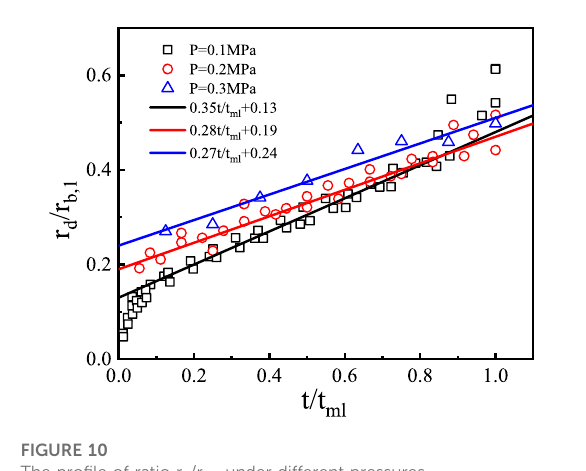
FIGURE 8 The evolution of dry spot radius, contact radius, and bubble radius.